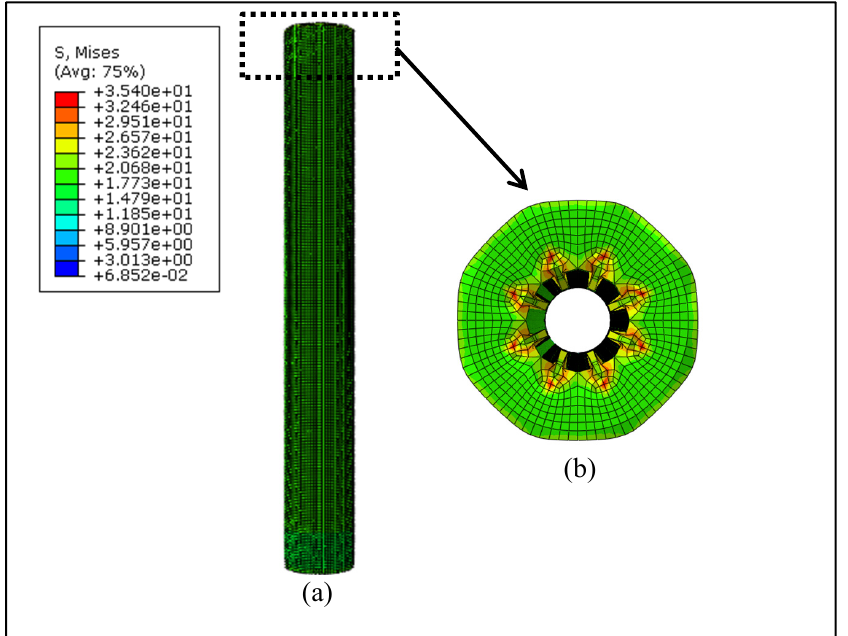
Figure 7. Predicted von Mises stress of circular hollow unconfined RC column (at the end of simulation analysis); (a) Front view (b) Upper plan view showing failure behavior on top of the